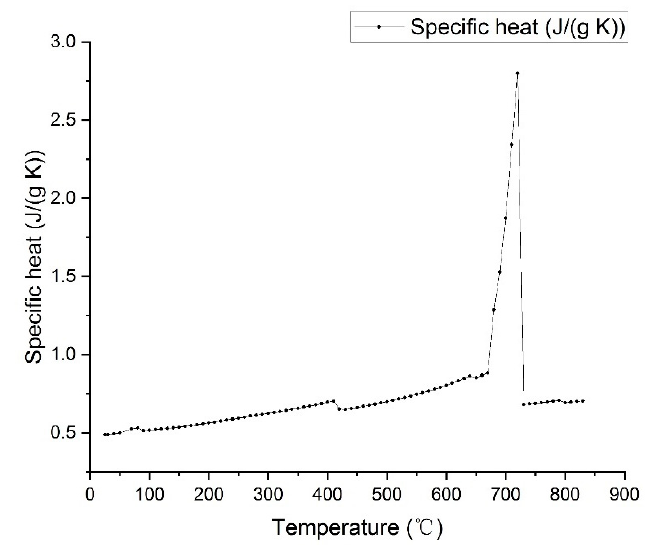
Figure 4. Specific heat of the surface.